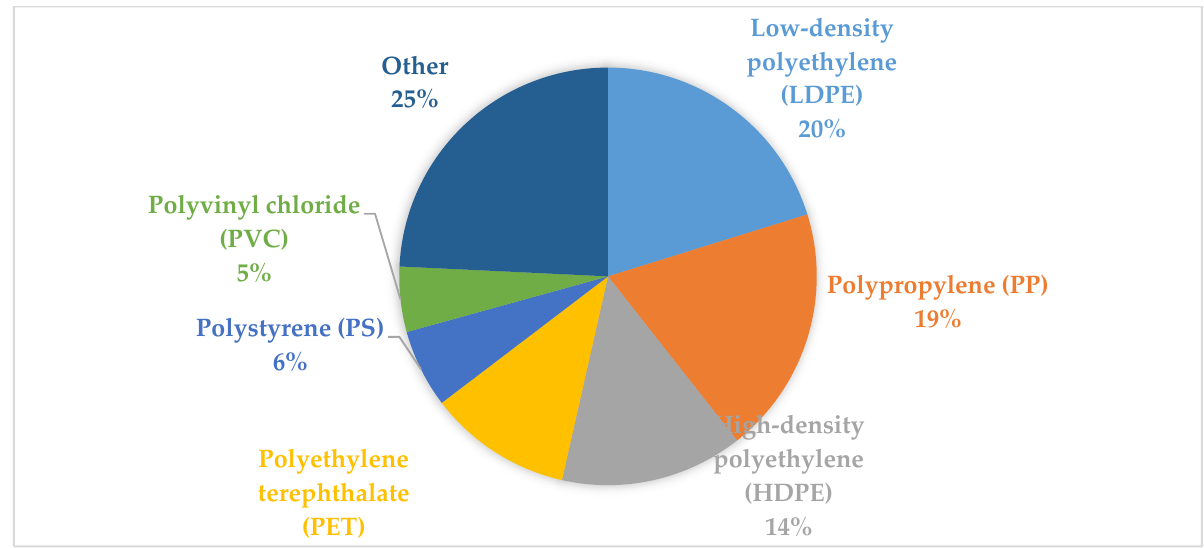
Figure 1. Distribution of plastic waste worldwide in 2015, by the type of plastic and an expected increase in demand due to COVID-19. Note: Other includes polycarbonate, Teflon, acrylonitrile, butadiene styrene. (Data source: National Geographic; Various sources (ASTM International, Association of Plastic Recyclers, Roland Geyer, University of California). Available online: https://www.statista.com/statistics/893594/plastic-waste-share-worldwide-by-type/) (accessed on 14 November 2020).